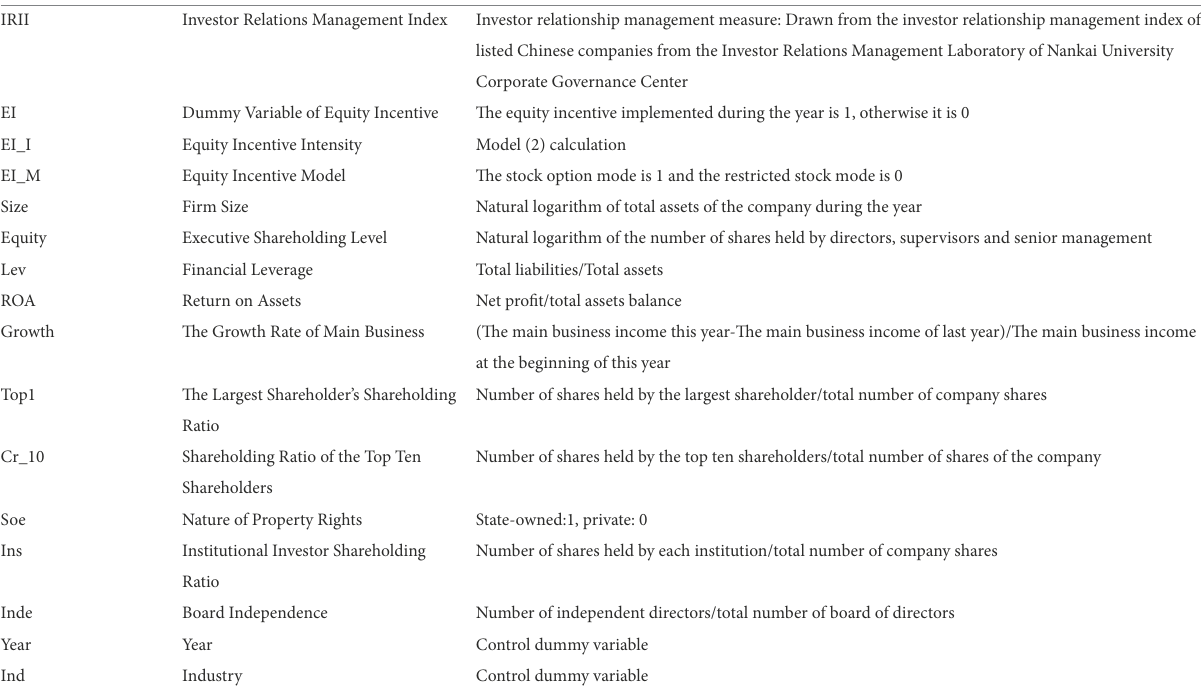
TABLE 1 Variable